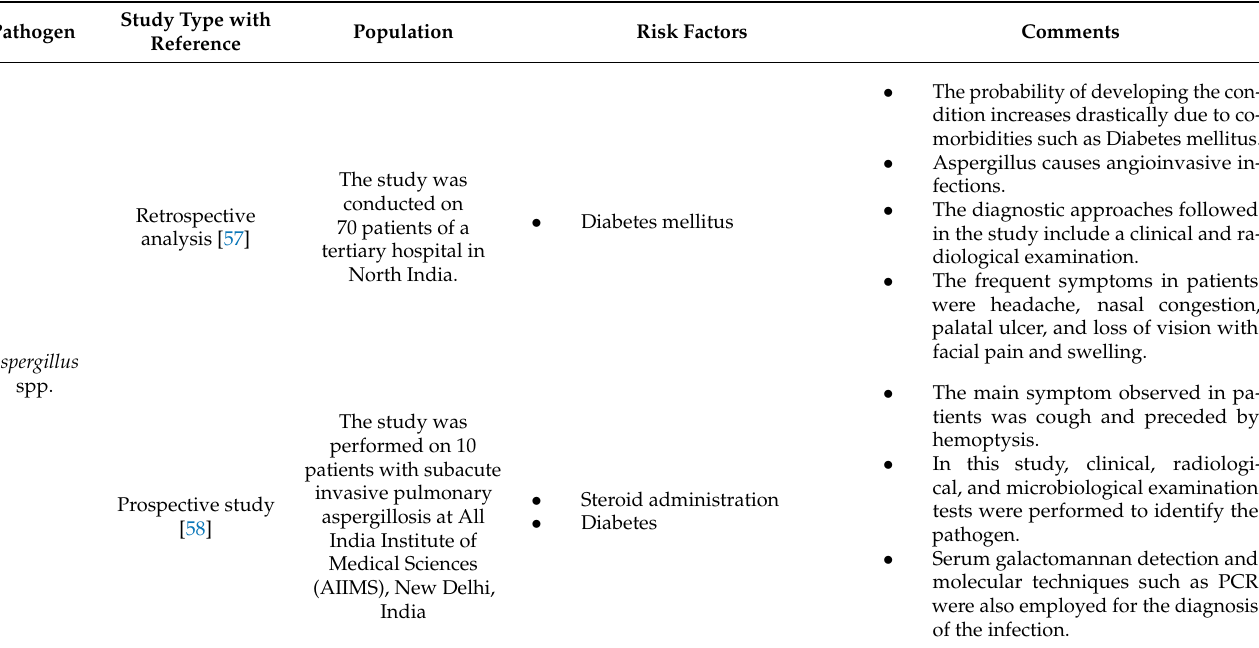
Table 1. Studies on opportunistic fungal infections in COVID-positive